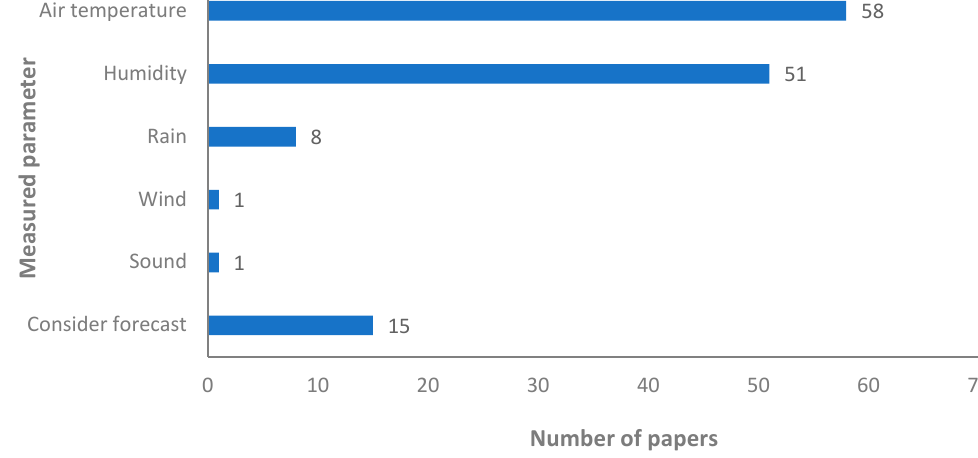
Figure 9. Number of included actuators in papers that propose an irrigation system.